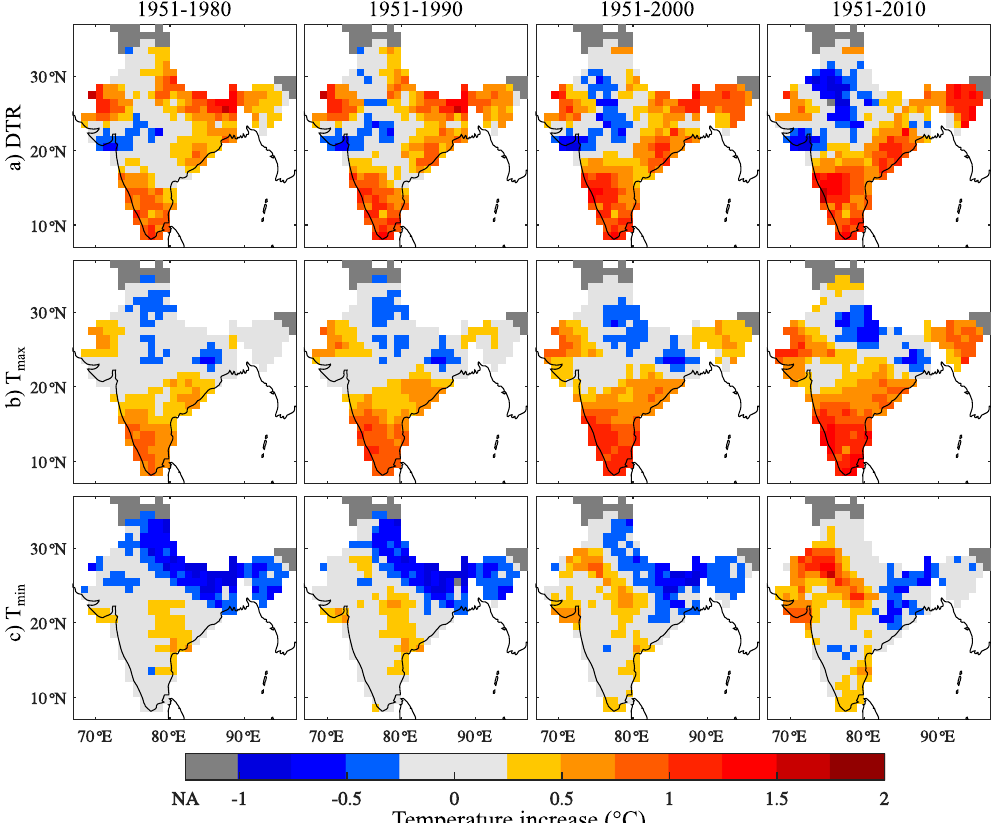
Figure 2. Spatial evolution of Ensemble Empirical Mode Decomposition trend of annual ( a ) DTR, ( b ) Maximum and ( c ) Minimum temperatures. Each sub panel has four time windows 1) 1951–1980, 2) 1951–1990, 3) 1951–2000 and 4) 1951–2010. Grids with inconsistent data are shown in dark grey colour (extreme left of colour bar), which is represented as NA (Not Analysed). ± 0.25 °C range is assigned a light grey colour for easy distinction of positive and negative trends. The maps were generated using the software MATLAB (version 2014b)